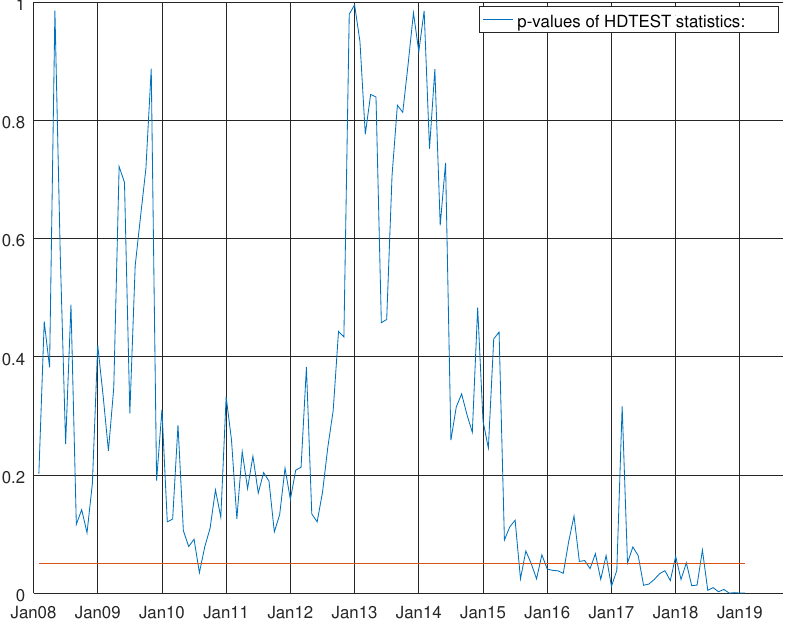
Figure 17. Graph showing the p -values of the Harvey heteroskedasticity test for the enhanced model for capital goods. The null hypothesis states that the residuals are not